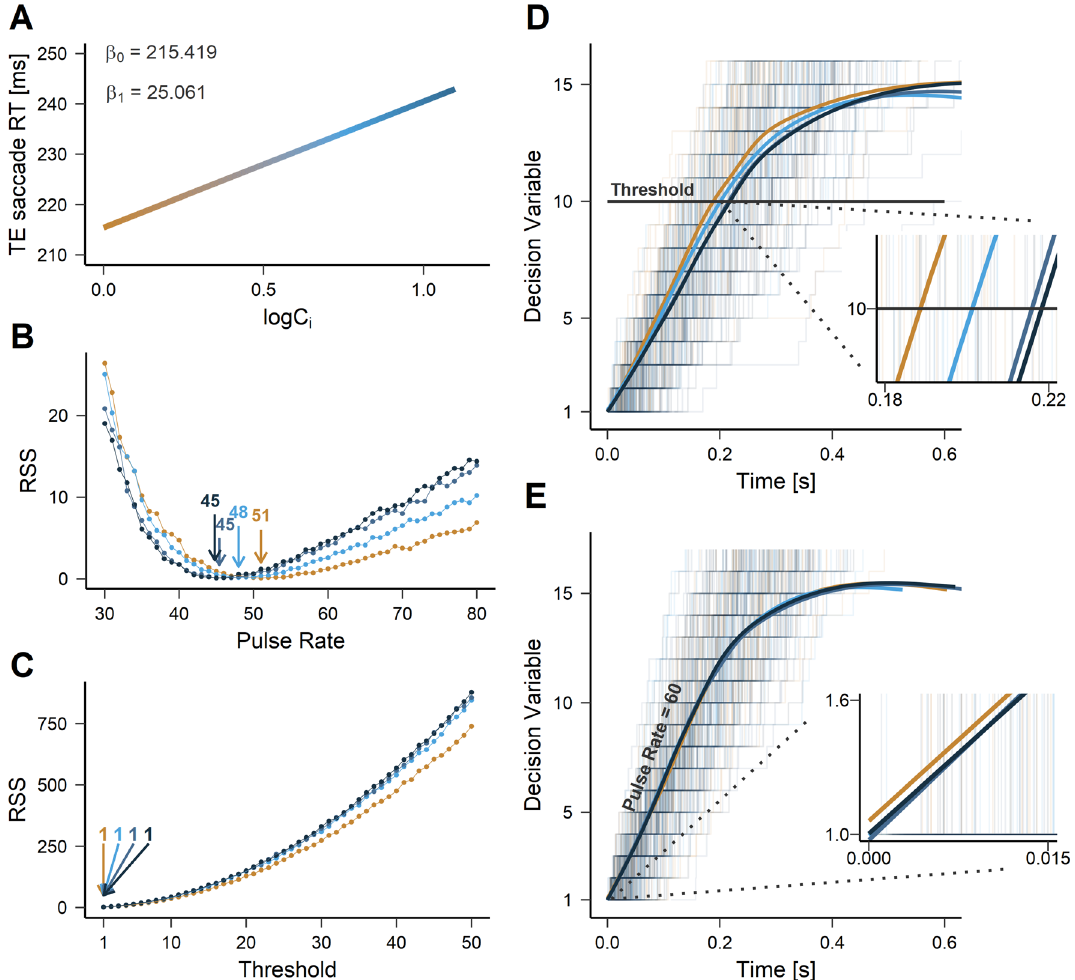
Figure 6. ( A ) Fit of the Hick’s model to saccadic reaction time. Predicted visually-guided RT plotted as a function of log(number of choices). ( B ) Residual sum of squares (RSS) of the comparison between empirical data and R V / T C predictions. The plot was U-shaped with a variable minimum between conditions. ( C ) RSS of the comparison between empirical data and R C / T V predictions. The RSS plot was exponentially shaped with a fixed arbitrary minimum identical in all conditions. ( D ) R V / T C model. Fifty simulations trials (light traces) per condition are displayed with the mean path for every condition (dark lines). The horizontal line indicates the constant threshold. ( E ) R C / T V model. See text for